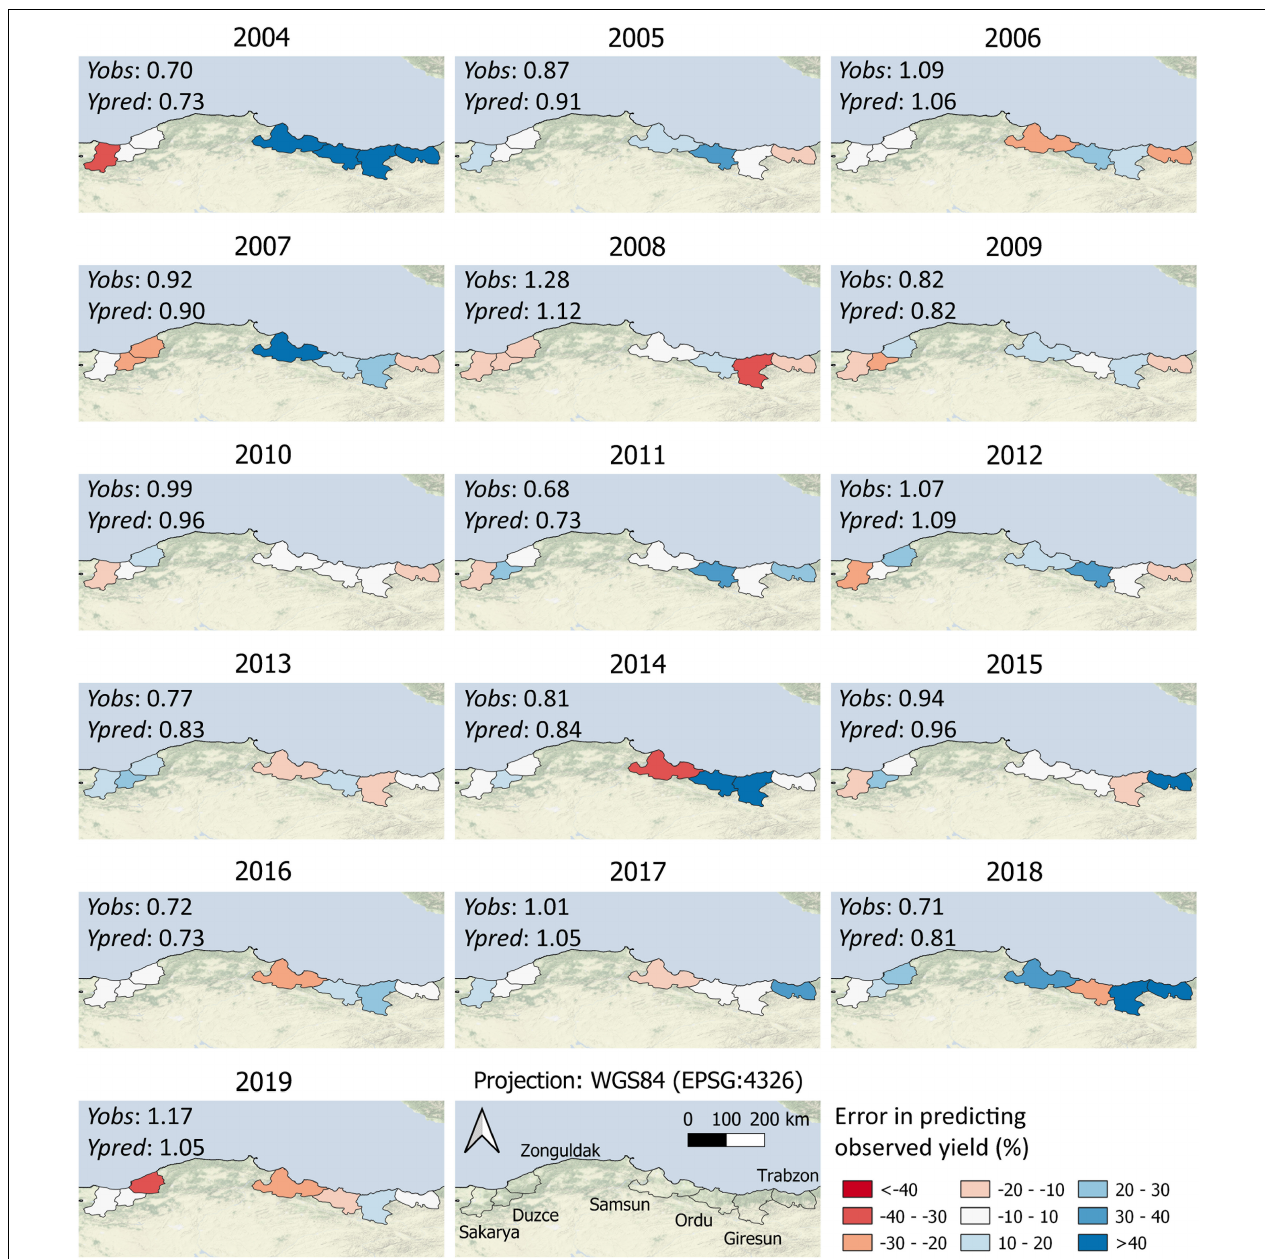
FIGURE 6 | Median model results in terms of percentage error in predicting official yield per municipality and year. The maps report the comparison between absolute values of official ( Yobs ) and predicted yield ( Ypred